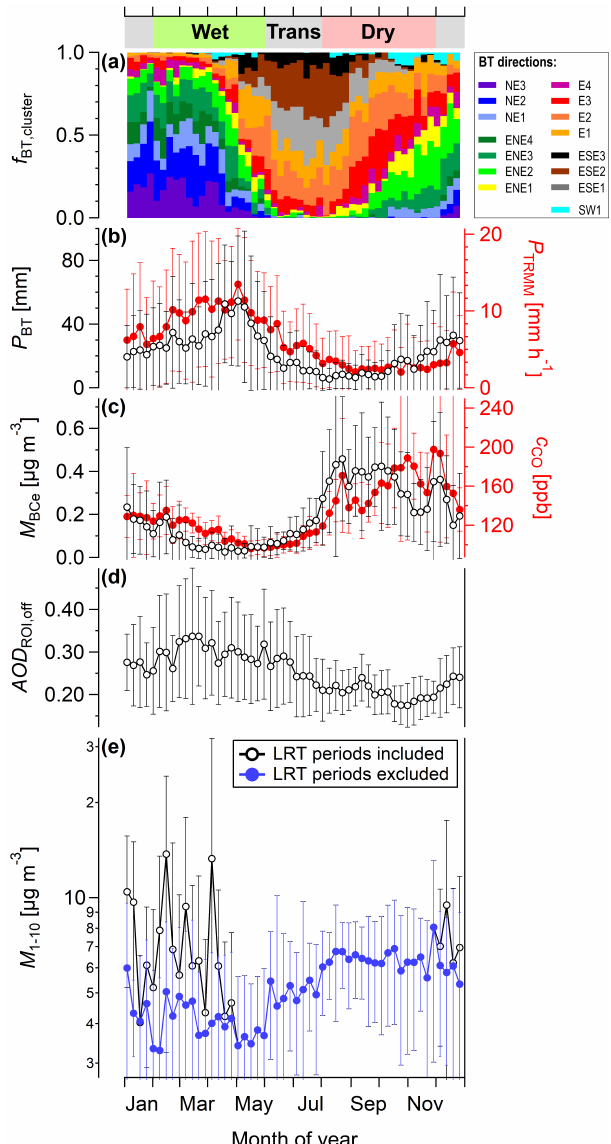
Figure 4. Seasonal cycle of selected meteorological, trace gas, and aerosol parameters in the central Amazon. (a) Weekly frequency of occurrence of backward trajectory clusters according to Pöhlker et al. (2018). (b) Precipitation products P BT , representing cumulative precipitation along BT tracks, and P TRMM , representing TRMM- derived precipitation within ROI ATTO (see Fig. S4). (c) Pollution tracers BC e mass concentration, M BCe , and carbon monoxide mole fraction, c CO . The BC e data includes ATTO and ZF2 site measure- ments, spanning from 2008 to 2017. CO data includes ATTO site measurements from 2012 to 2017. (d) MODIS-derived AOD data within ROI off as defined in Fig. S4, spanning from 2000 to 2016. (e) OPS-based coarse mode aerosol mass in two configurations: with and without LRT peaks, according to Table 1. Data are shown as weekly averages with error bars representing one standard devi-